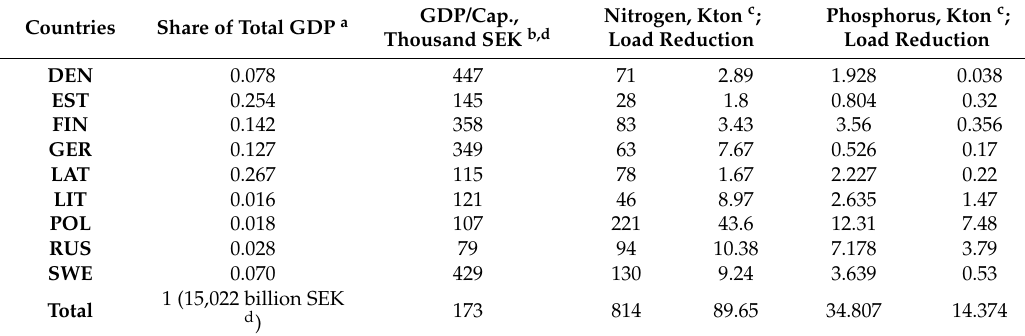
Table A1. Shares of total GDP, GDP/capita in 2015, nutrient loads and BSAP reduction requirements for the different countries.